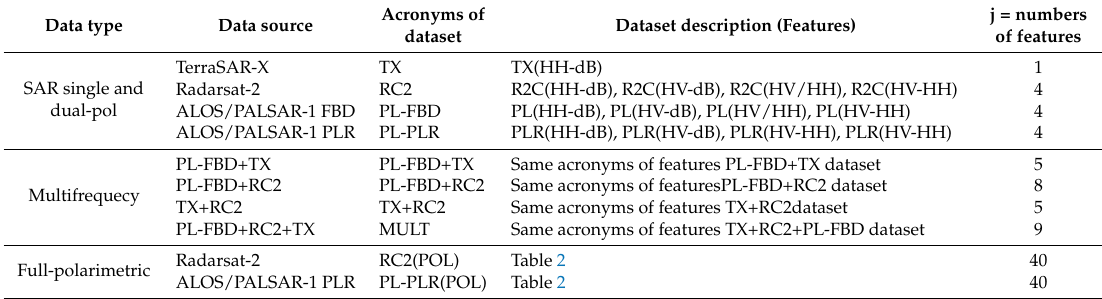
Table 3. Definition, acronyms and description of SAR predictor sets. The description and acronyms of features composing the single and dual-pol groups (Table 2) are highlighted in gray. The original datasets identified by the symbol * in the Table 2 are replaced by their acronyms shown in the third column of this